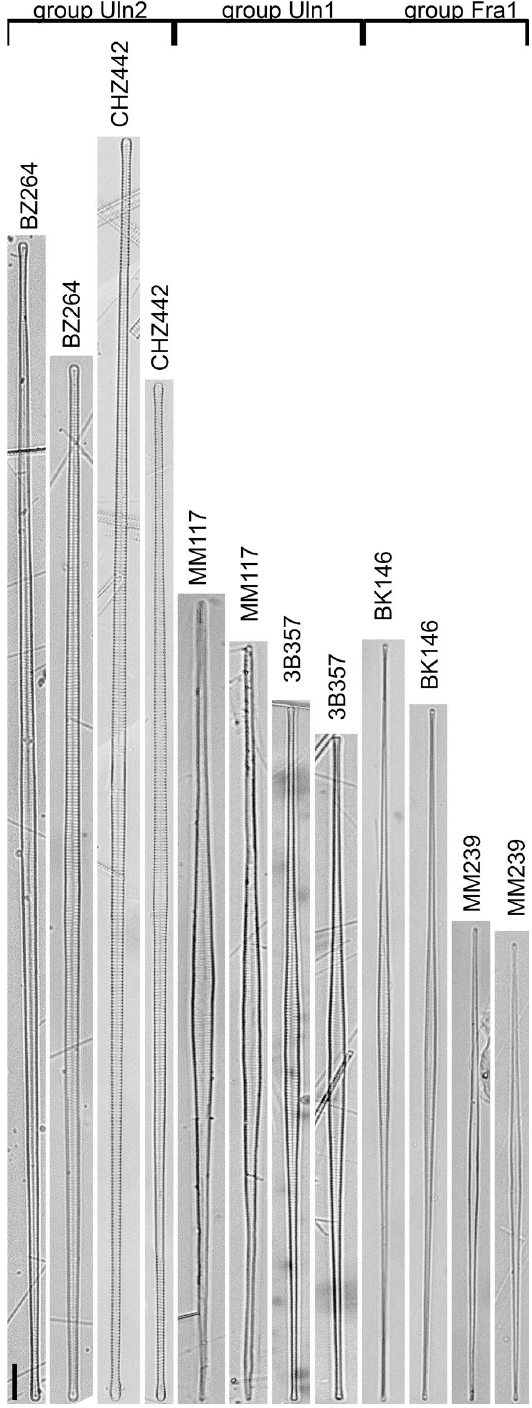
Figure 4. Valves of strains of Uln1 group (MM117 and 3B357), Uln2 group (BZ264 and CHZ 442), Fra group (BK146 and MM239). LM. Scale bar: 10 μm.